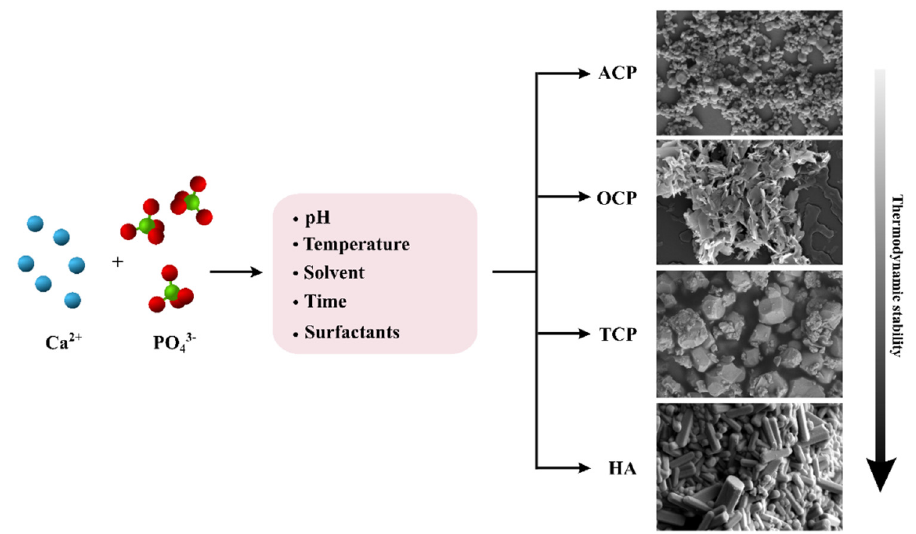
Figure 2. Principal synthesis parameters that influence the characteristics of calcium phosphates as well as the formation of different crystal phases (ACP: amorphous calcium phosphate, OCP: octacalcium phosphate, TCP: tricalcium phosphate, HA: hydroxyapatite).